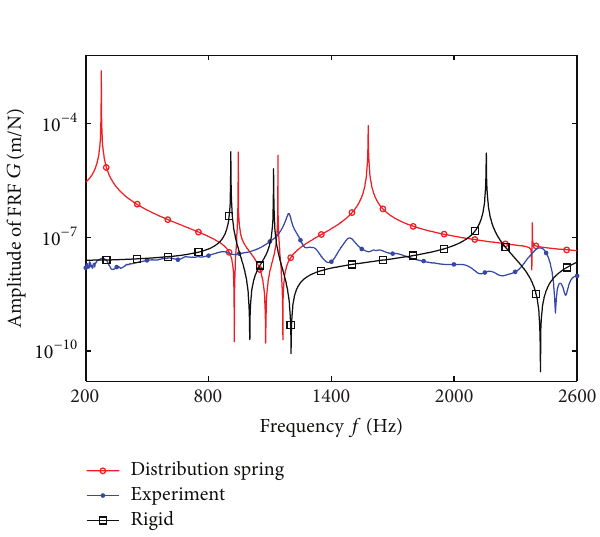
Figure 10: The comparison of FRF at tool